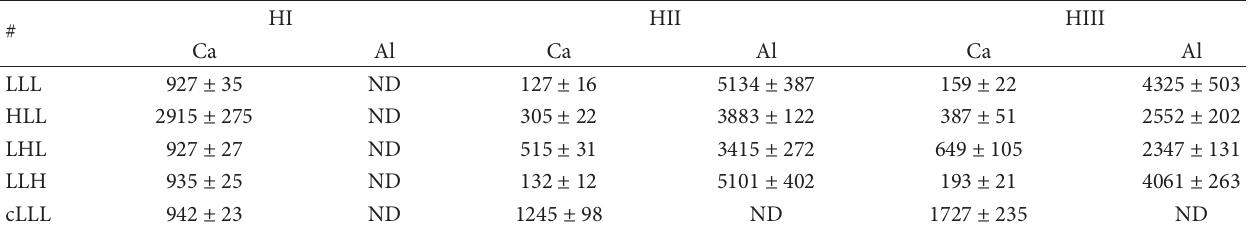
# Treatment condition: 3 letters indicate 3 weeks. c stands for control. L = 250𝜇 M Ca. H = 2500𝜇 M Ca, and ND: not detected.